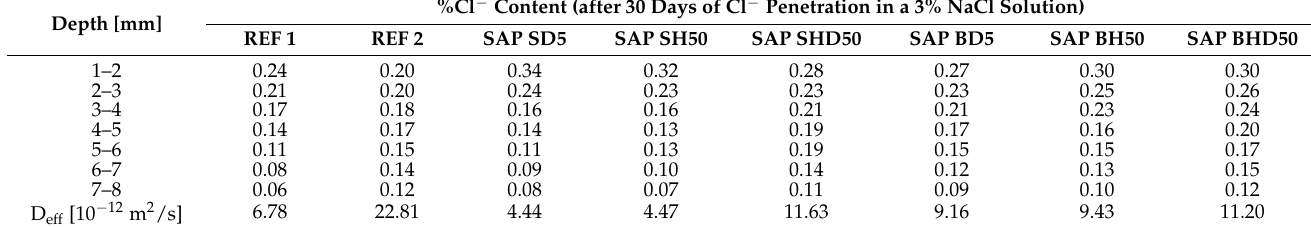
Table 8. The chloride ion diffusion coefficient and the percentage chloride ion content in each 1-mm wide layer of tested concrete